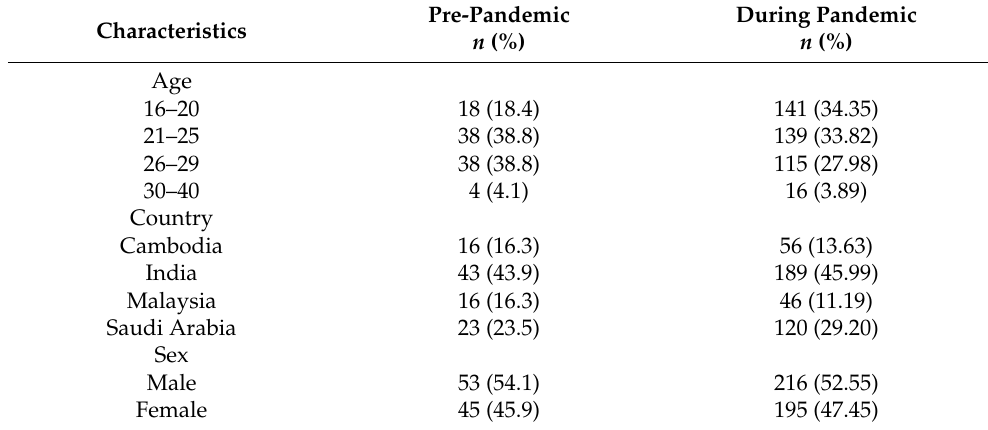
Table 1. Participants’ demographic